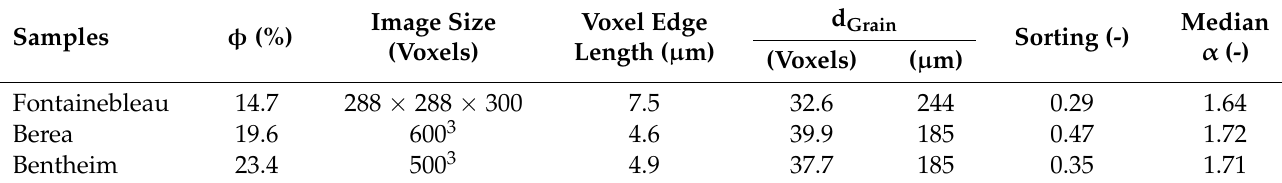
Table 1. Image size, resolution and granulometric properties of the investigated micro-CT scans (Fontainebleau, Berea and Bentheim